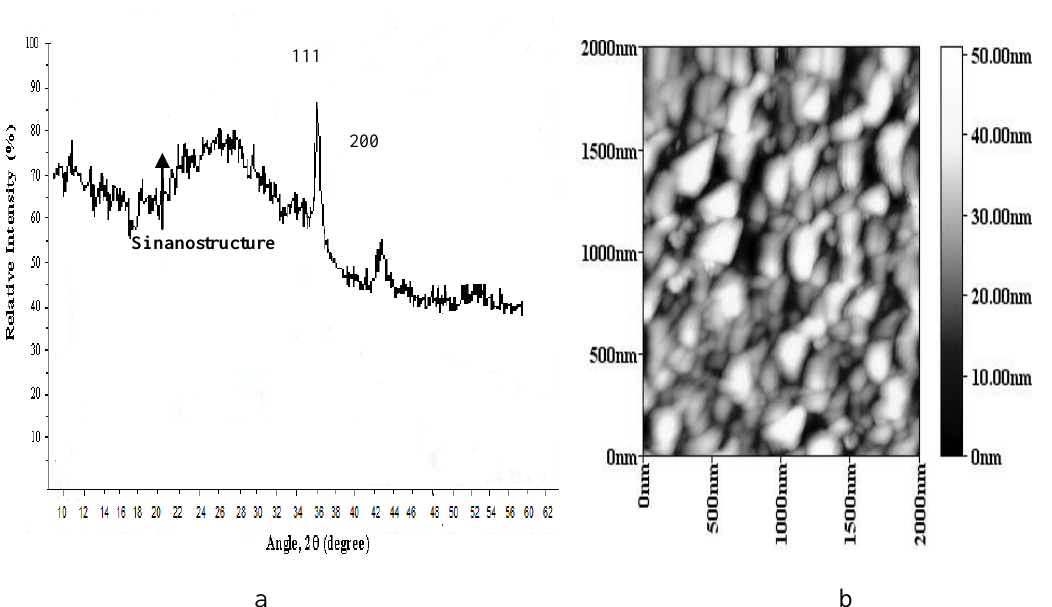
Fig.2: a-X-ray diffraction b-Surface morphology of Cu